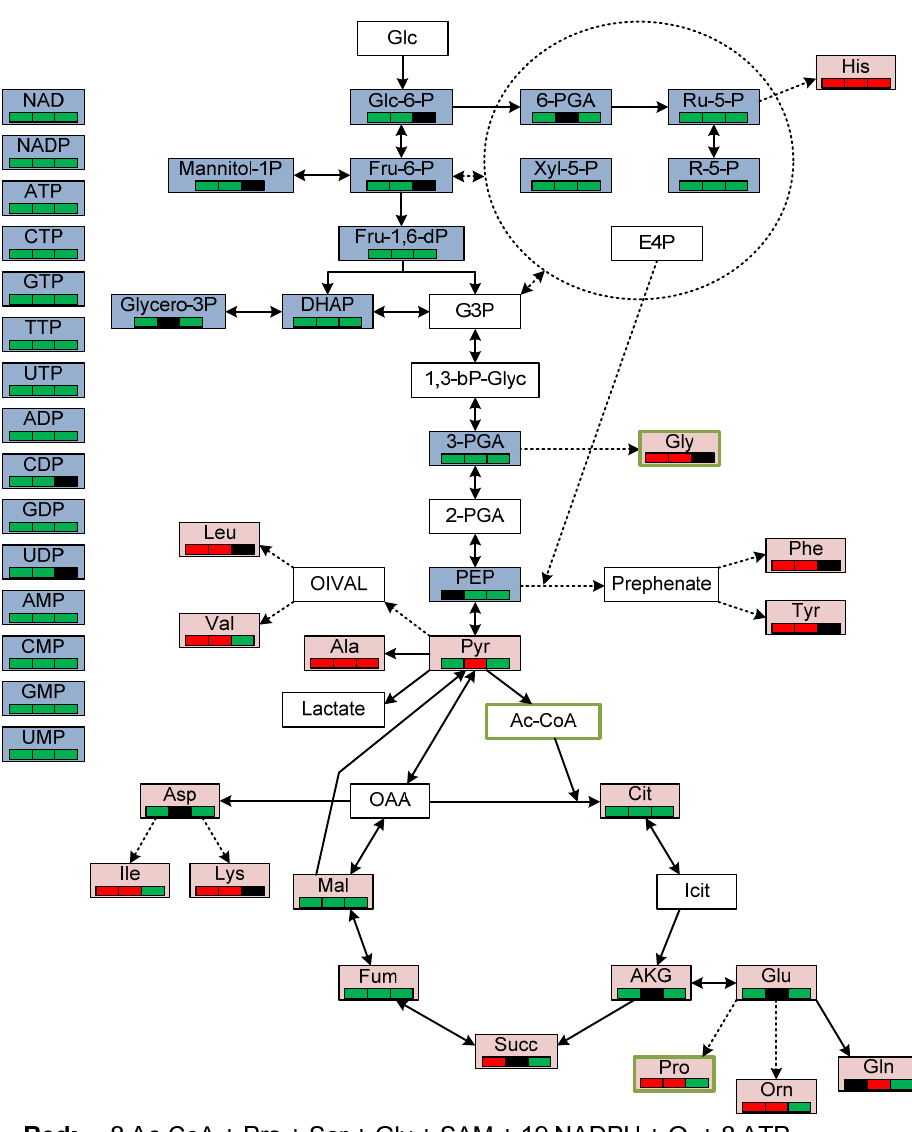
Figure 3. Scheme of central metabolic pathways in Streptomyces coelicolor with a special emphasis on metabolites covered by the present study (upper part). Blue color indicates metabolites detected by the LC-MS/MS method; red color indicates metabolites detected by the MCF GC-MS method. Lower part, stoichiometric equations for the biosynthesis of Act, Red and CDA. The precursor metabolites of Act and Red are indicated with green frame color in the metabolic network scheme. Colored boxes below metabolite names correspond to the three time-course experiments (left: M145, SSBM-P, middle: INB201, SSBM-P, right: M145, SSBM-E) and indicate the following metabolite profile classifications: 'red' (increased concentration in response to nutrient depletion), 'black' (no significant change in response to nutrient depletion), and 'green' (decreased concentration in response to nutrient